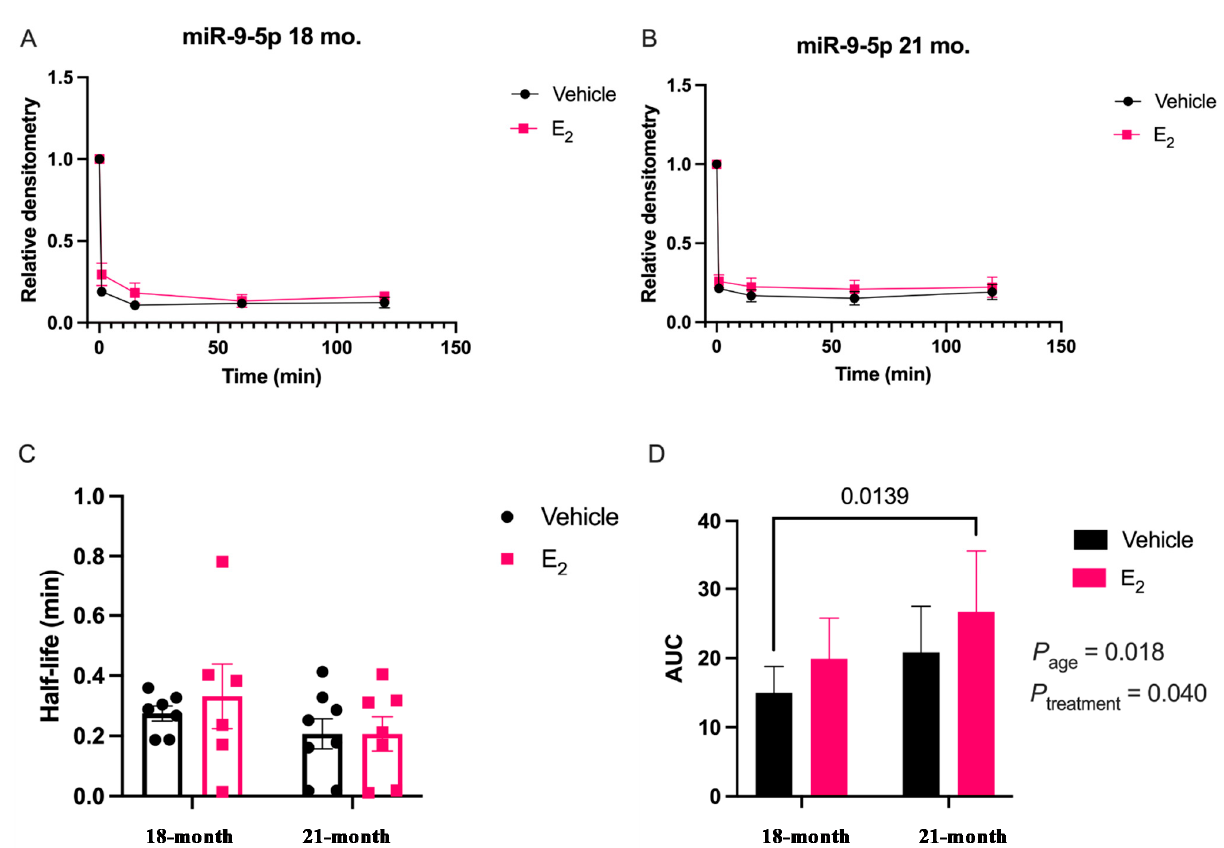
Figure 3. E 2 treatment increased miR-9-5p stability in the paraventricular nucleus of the hypothalamus in a rat model of menopause. Aged female rats were ovariectomized at 18 months and treated with E 2 at 1 or 12 weeks following OVX. miRNA degradation assays were performed using brain tissue lysate isolated from the PVN of the hypothalamus. ( A ) Scatterplot of normalized densitometry values were analyzed from microradiographs and fit with a non-linear exponential decay function in 18-month or ( B ) 21-month-old animals (black line = vehicle; red line = E 2 ; N = 8/group). ( C ) Mean half-life and ( D ) area under the curve (AUC) of miR-9-5p calculated from best-fit exponential decay functions. Results are represented as mean ± SEM ( N = 8/group) and analyzed using two-factor ANOVA for Age and Treatment. Significance was noted when p < 0.05. Significant main effects of factors are noted as P subscript .